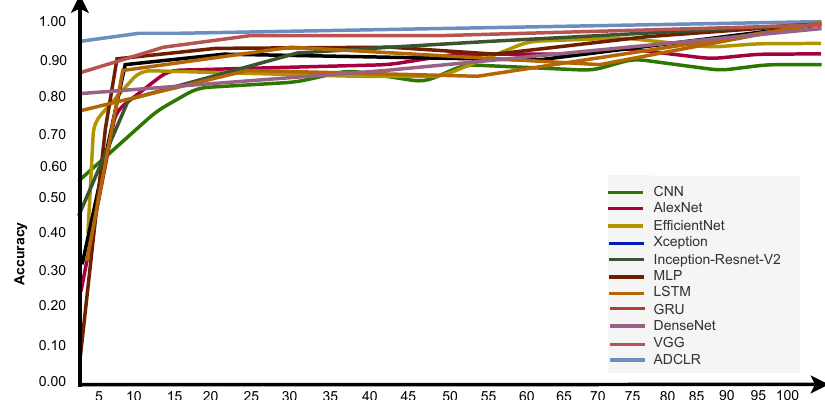
Figure 15. Comparison of state of the art method [28,29,34,37,39,48,50].